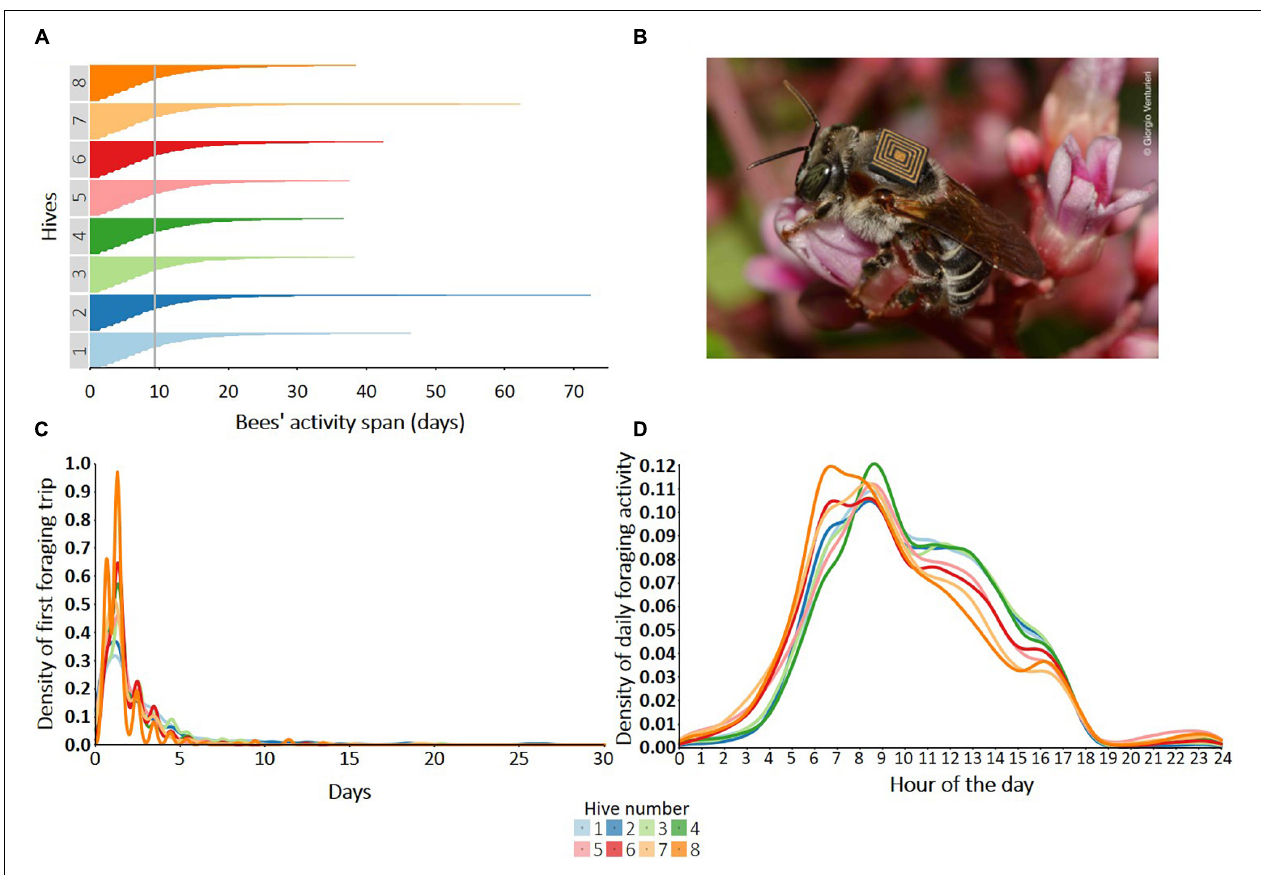
FIGURE 2 | (A) Workers extranidal activity span based on the difference between the last reading on the RFID system and the day they were tagged. Different colonies are plotted on the y axis with every row corresponding to an individual bee sorted by activity span. The vertical gray line represents the mean activity of 9.3 days. (B) Picture of a M. fasciculata forager with a RFID tag on her thorax. Photo by GV. (C) Kernel density estimate plot of the bees’ first foraging trip calculated as the difference between the tagging data and the first record on the reader. (D) Kernel density estimate plot calculated by the overall frequency of reads per colony per day displaying the bees’ activity throughout the day. Peak activity was recorded between 5:00 to 10:00 in all